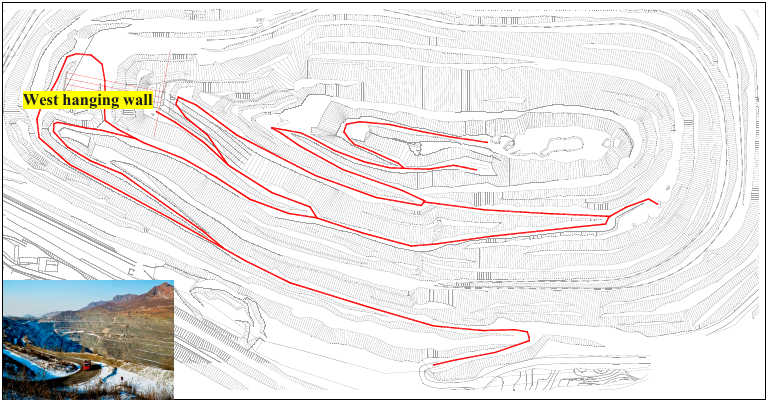
Figure 8. Geo-structure map of Yanqianshan Iron Mine.